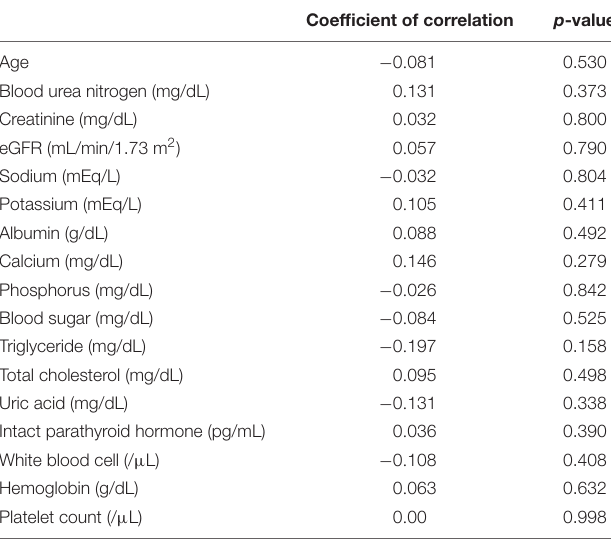
TABLE 4 | the correlation between and NfL and the biochemical/hematologic data in total population.